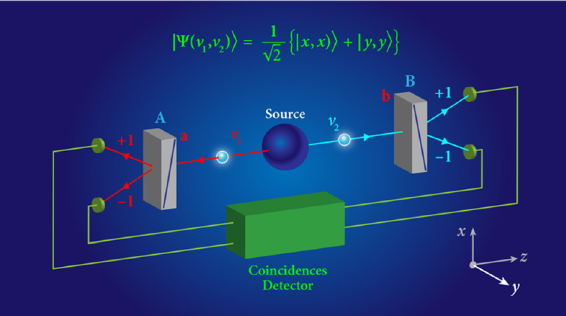
Figure 9: The apparatus for performing the Bell test. A source emits a pair of entangled photons v 1 and v 2 . Their polarizations are analyzed by polarizers A and B (grayblocks) aligned along the directions a and b. Each polarizer has two output channels labeled as + 1 and − 1. The fi nal correlation of the photons can be determined by the coincidence detectors (SNSPDs) (APS/Alan